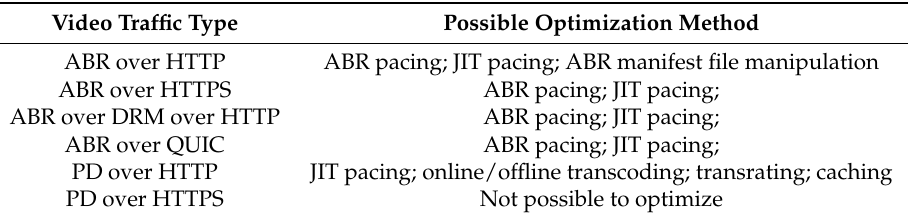
Table 1. VO optimization methods and traffic